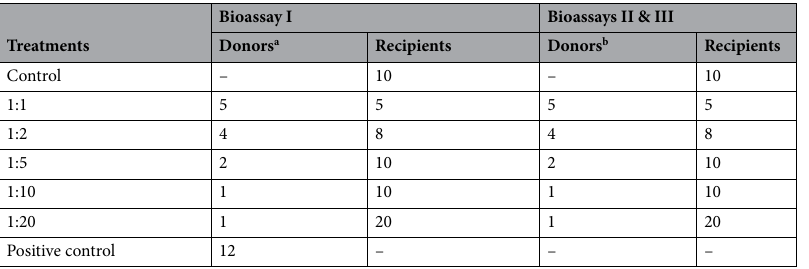
Table 1. Summary of treatments used in bioassays on Kuschelorhynchus macadamiae in the laboratory. a The number of fungus-infected adults used as donors in the experiment. The fungus-infected adults were initially painted with permanent red pen ink and infected with fungal suspension at their LC 95 conidial concentrations, followed by high humidity incubation (> 95% RH) for 24 h before being introduced to the recipients. b The number of conidiated cadavers used as the donors in the